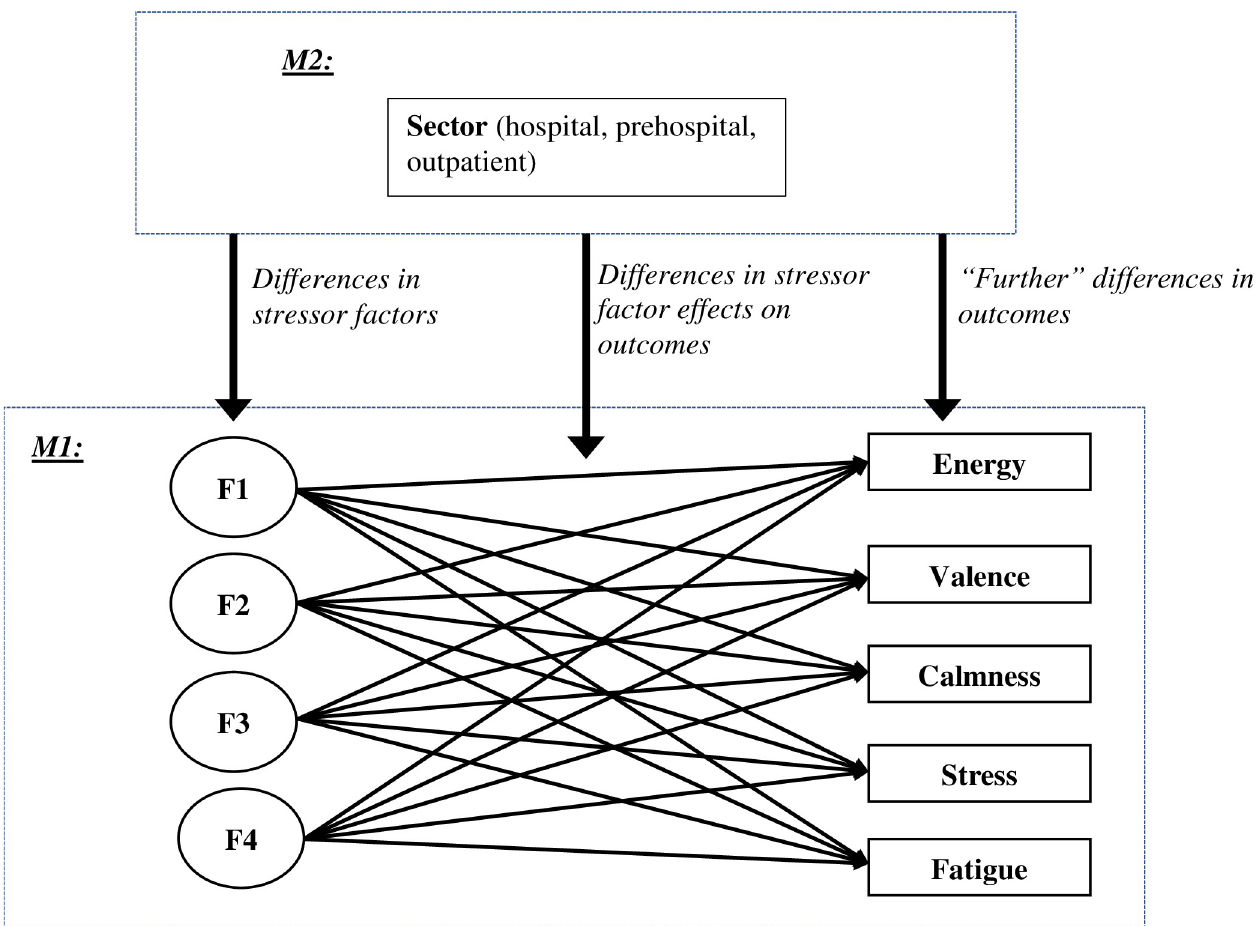
Fig 1. Structural equation modeling: Analysis plan. F = factor, F1 = fear of transmission, F2 = interference of workload with private life, F3 = uncertainty/ lack of knowledge, F4 = concerns about the team. M1 = Overall Model , M2 = Work Sector .